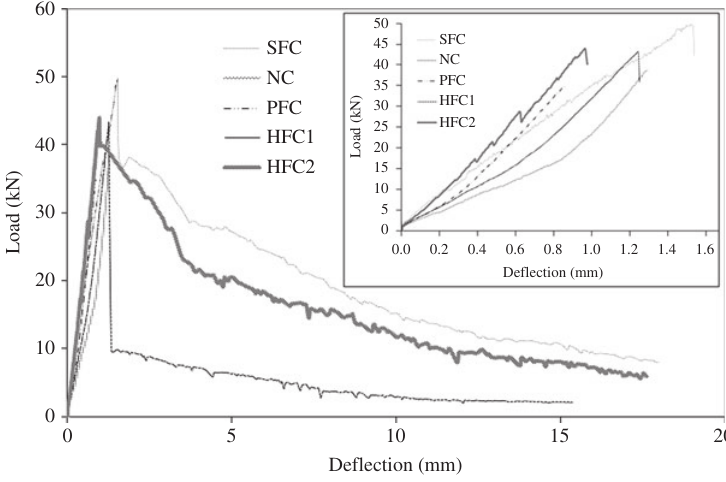
Figure 4 Load-defl ection curves of concrete